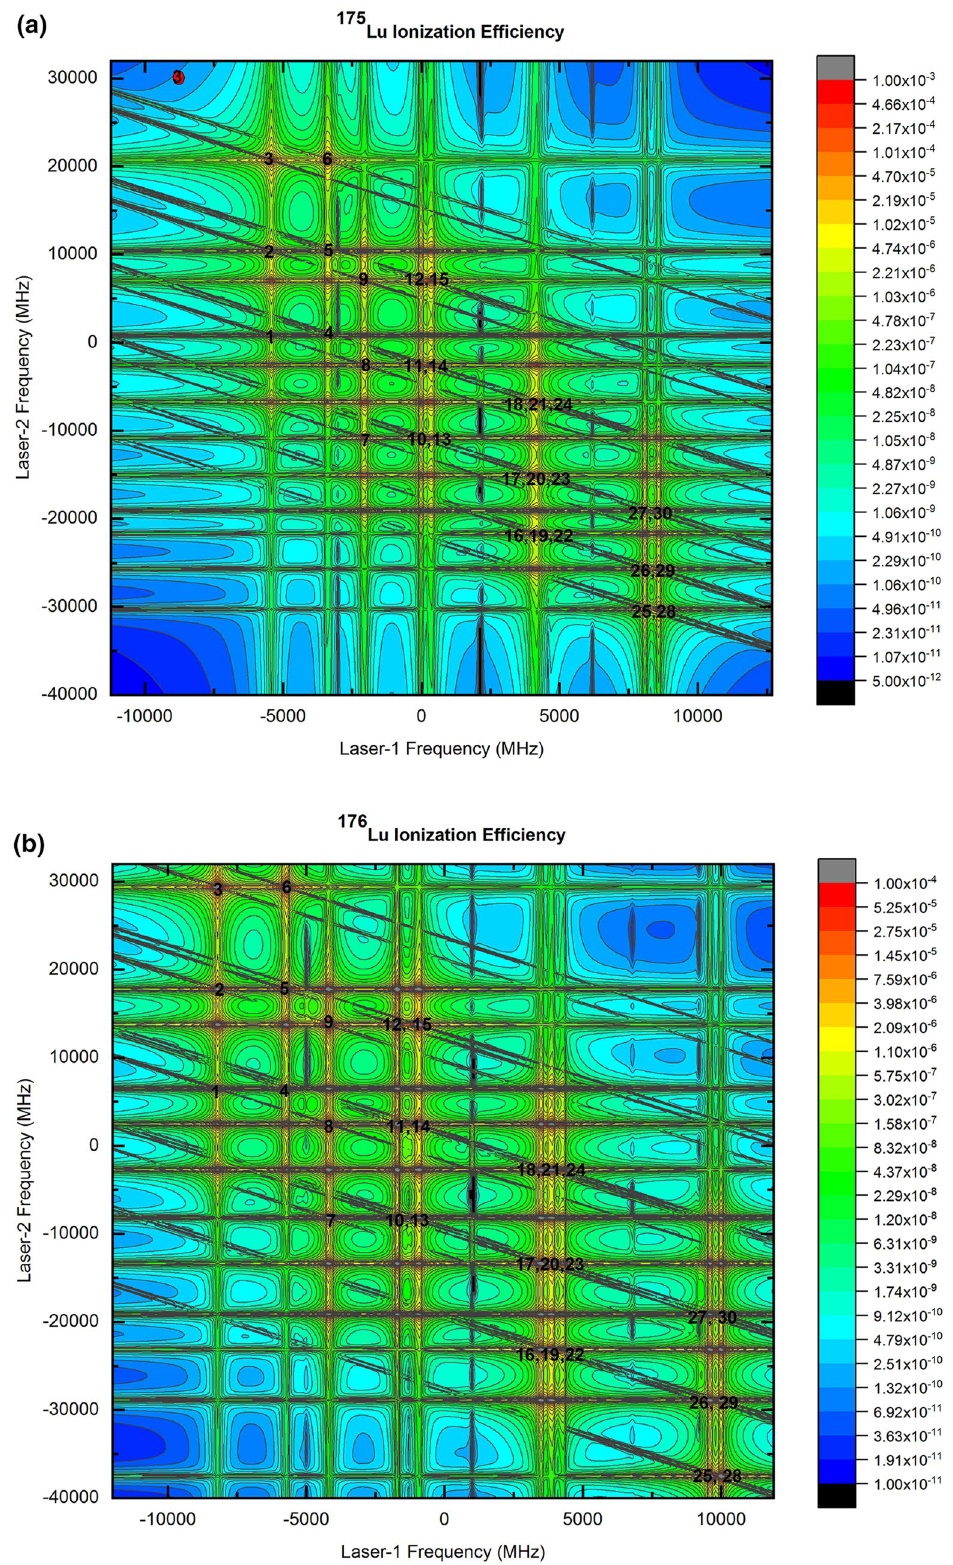
Figure 2. Two dimensional contour of the ionization efficiency of ( a ) 175 Lu and ( b ) and 176 Lu for the Doppler free condition and for a laser peak power density of 10 W/cm 2 and a bandwidth of 10 MHz for the excitation lasers. The resonance frequency positions of the hyperfine excitation pathways are numbered as per the Table 2. The resonance frequency position of the 17/2–17/2–19/2 of the 176 Lu is shown as “filled circle” in ( a